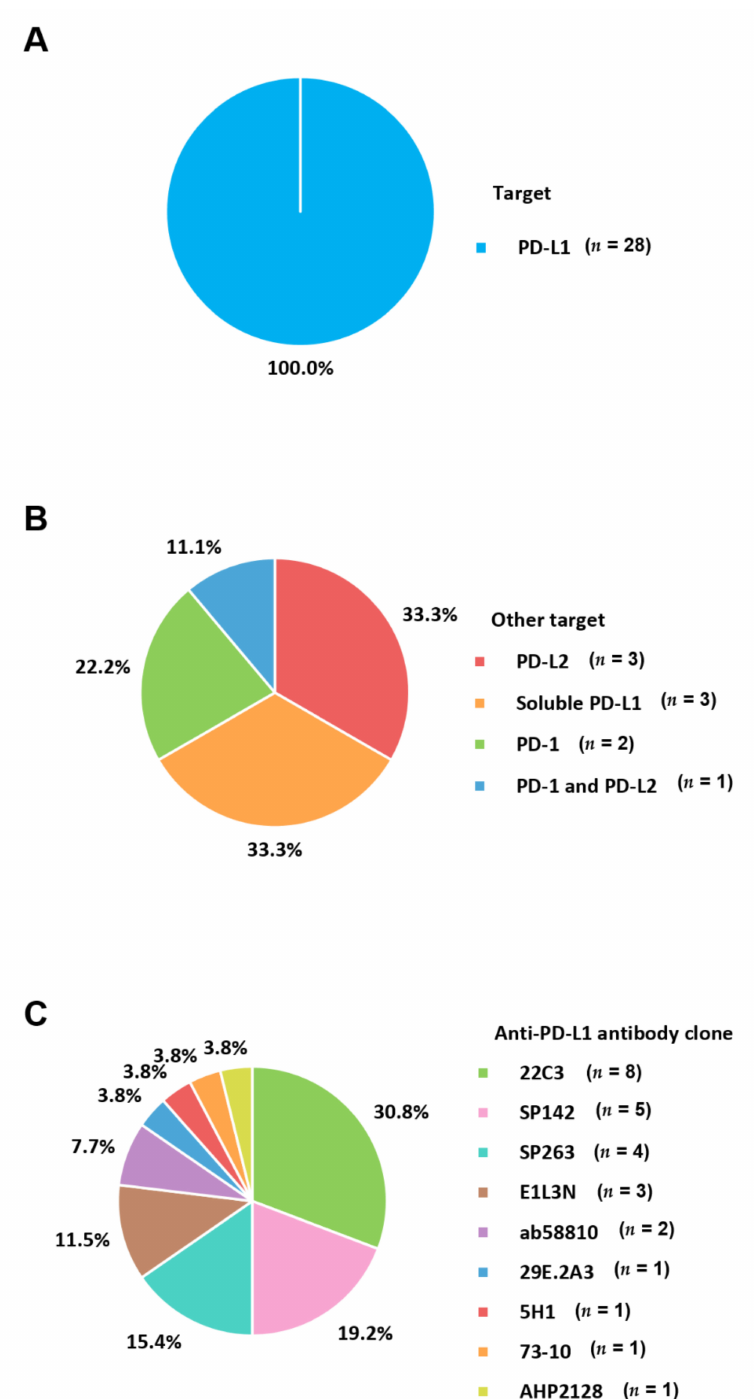
Figure 3. Targets of PD-1 axis and antibody clones for PD-L1. ( A ) Pie charts showing the target of PD-L1; ( B ) pie charts presenting other targets concurrently used with PD-L1; and ( C ) pie charts showing the antibody clones of PD-L1. PD-1, programmed cell death protein-1; PD-L1, programmed death ligand-1; PD-L2, programmed death